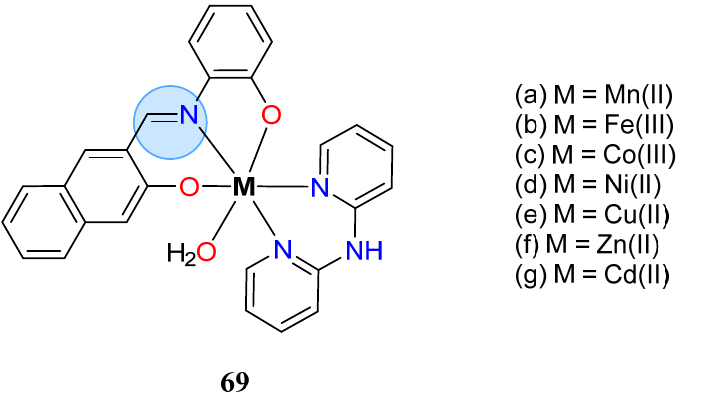
Figure 32. Metal(II) complexes with ONO tridentate Schiff bases and 2,2 ′‐ bipyridylamine.